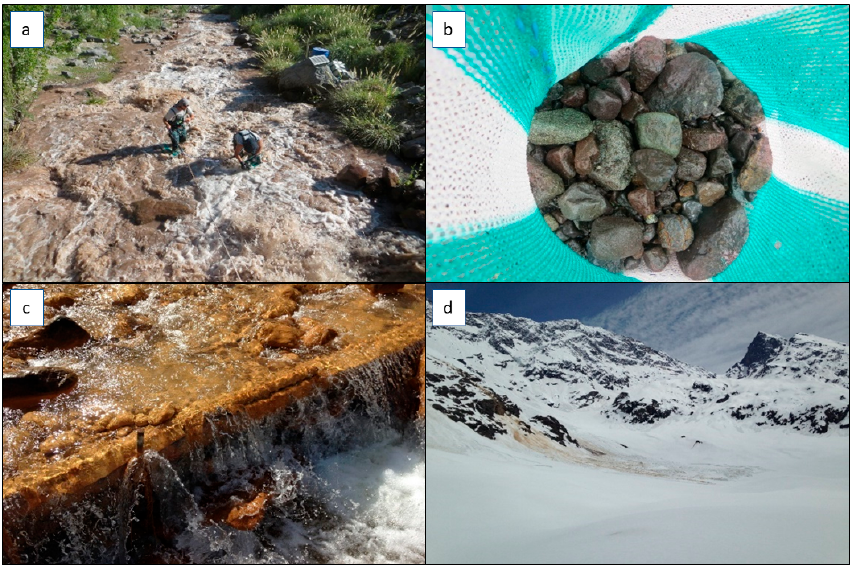
Figure 2. Sampling bedload transport during glacier melting at MS-A using Bunte samplers ( a ); a